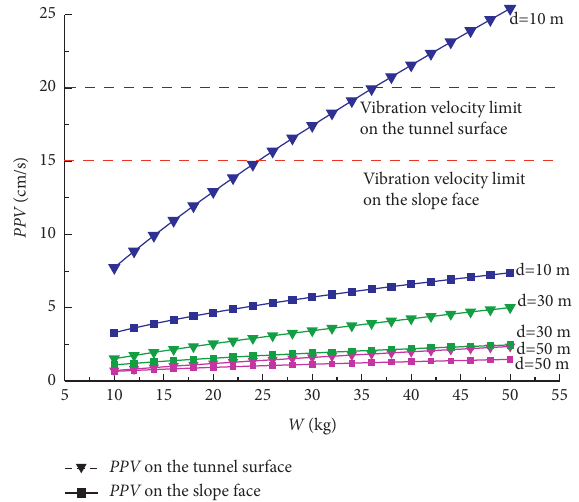
Figure 18: The relation curve between PPV, distance away from blasting ( d ), and W